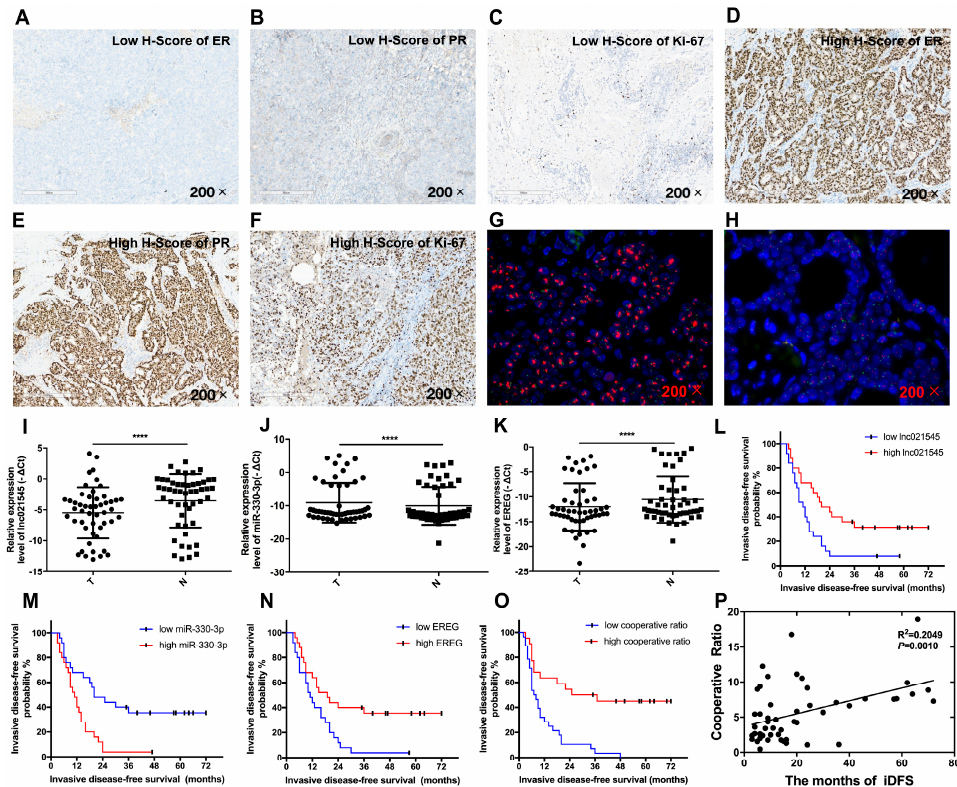
Figure 8. The clinical feature and cooperative effects of lnc021545, miR-330-3p, and EREG in BC patients. The images of BC patients’ specimens with low H-scores of ER ( A ), PR ( B ), and Ki-67 ( C ). The images of BC patients’ specimens with high H-scores of ER ( D ), PR ( E ), and Ki-67 ( F ). The images of BC patients’ specimens with HER-2 amplification ( G ); the images of BC patients’ specimens with HER-2 un-amplification ( H ). The expression level analyses of lnc021545 ( I ), miR-330-3p ( J ), and EREG ( K ) in adjacent non-tumor tissues and BC tissues. Kaplan–Meier curve of iDFS in the expression of lnc021545 ( L ), miR-330-3p ( M ), and EREG ( N ). Kaplan–Meier curve of iDFS in the cooperative ratio ( O ). Correlation between cooperative ratio and months of iDFS in 50 BC tissues ( P ). (**** p < 0.0001, n = 50).